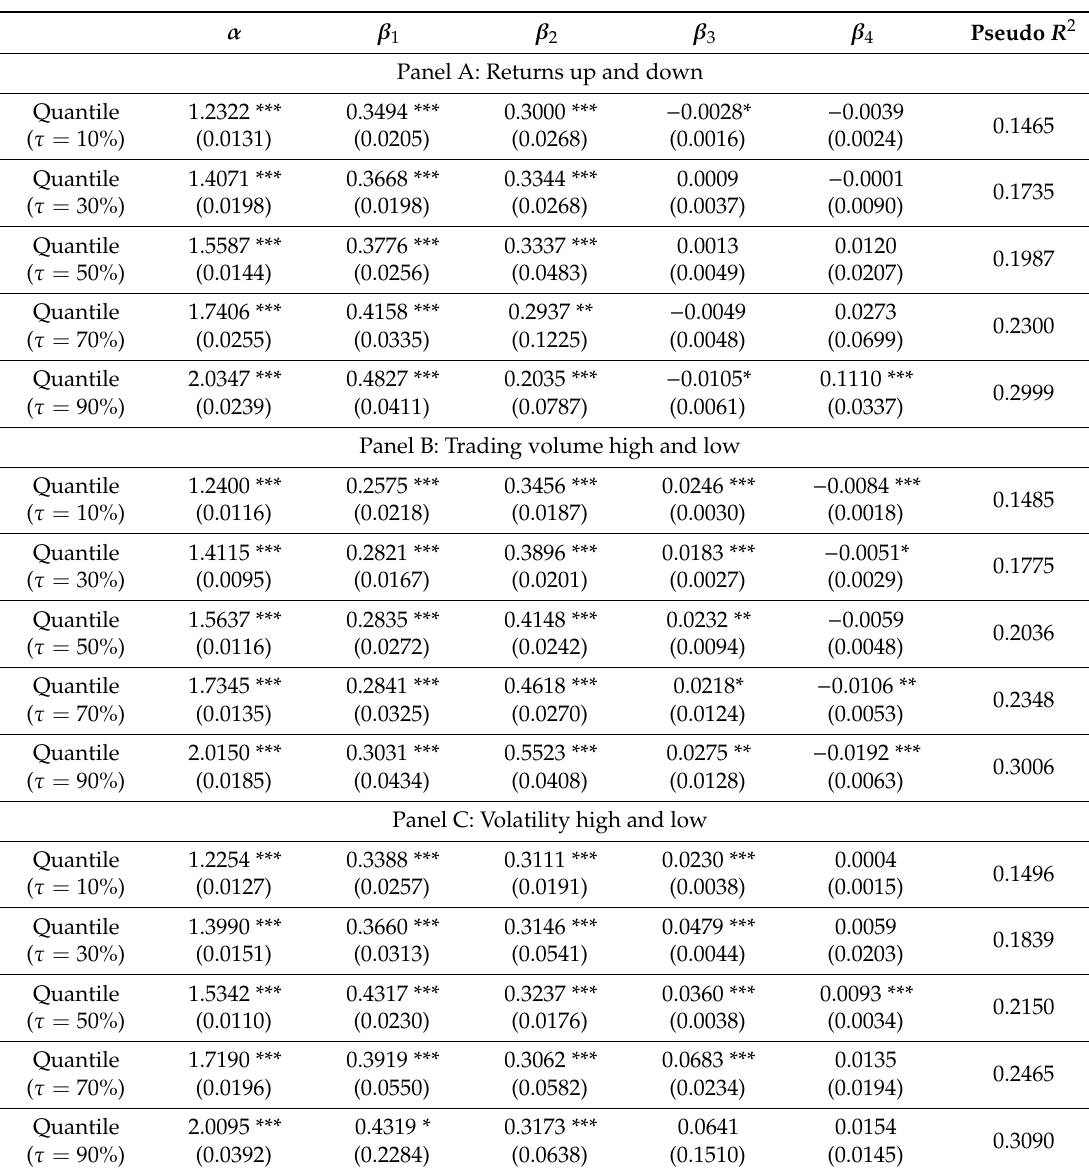
Table 6. Quantile regressions on estimates of herding behavior in market conditions in